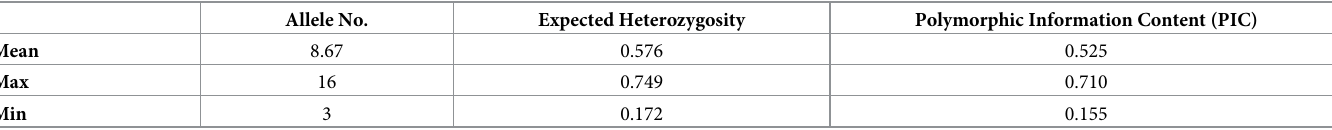
Table 2. Summary of genetic diversity calculated for the 107 SSR markers used in genotyping the 186 palms. Allele No.